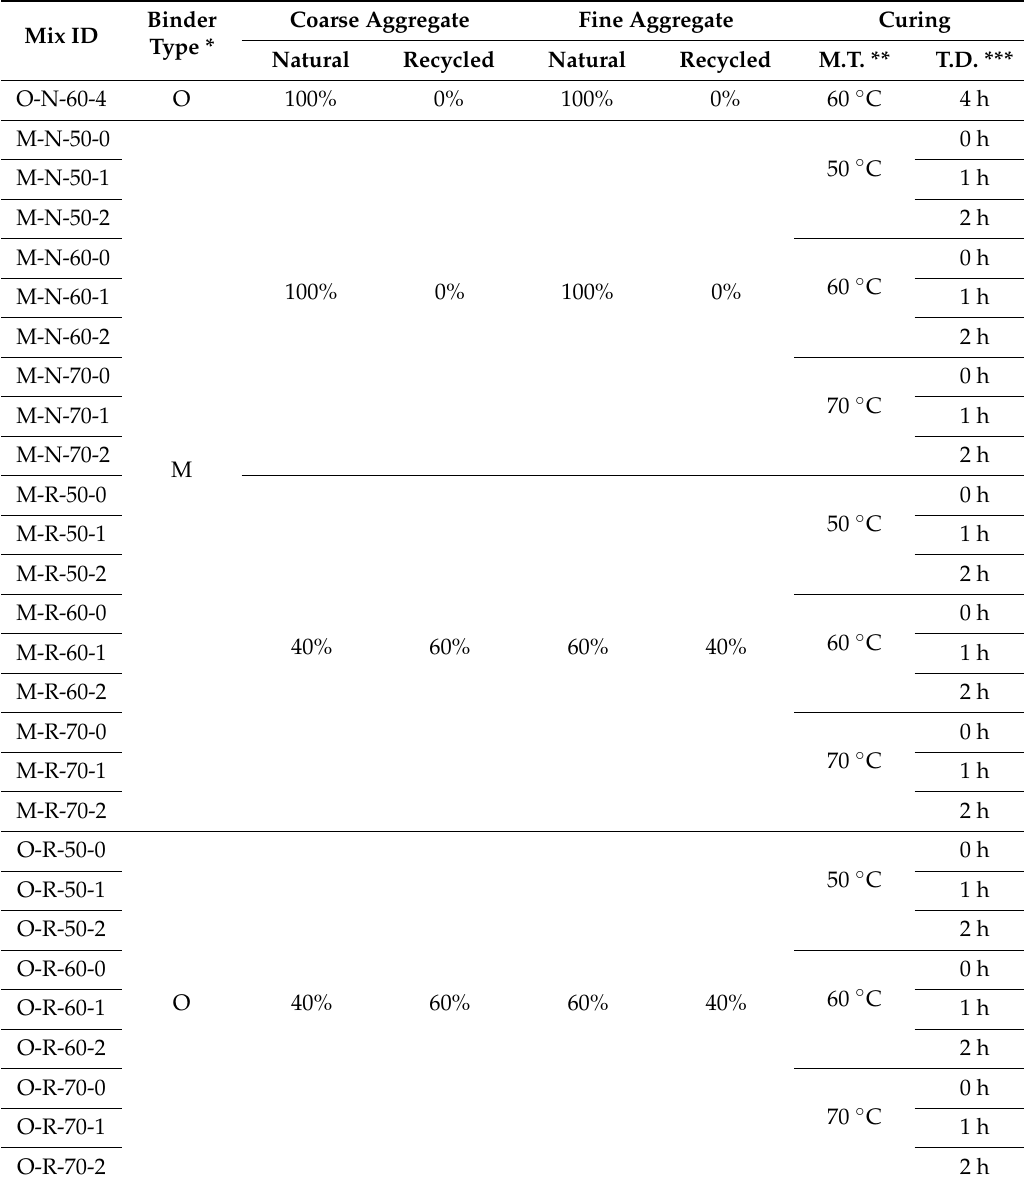
Table 3. Mix details and steam-curing regimes